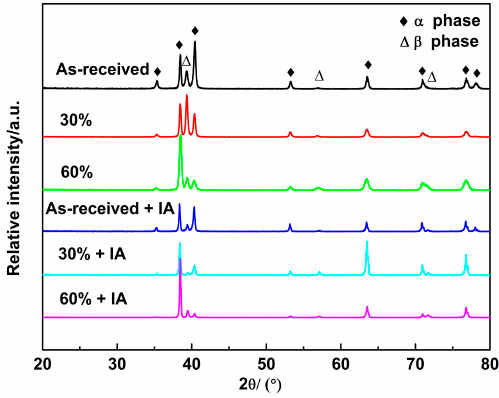
Figure 3. XRD patterns of VT3-1 alloy under different processing conditions.